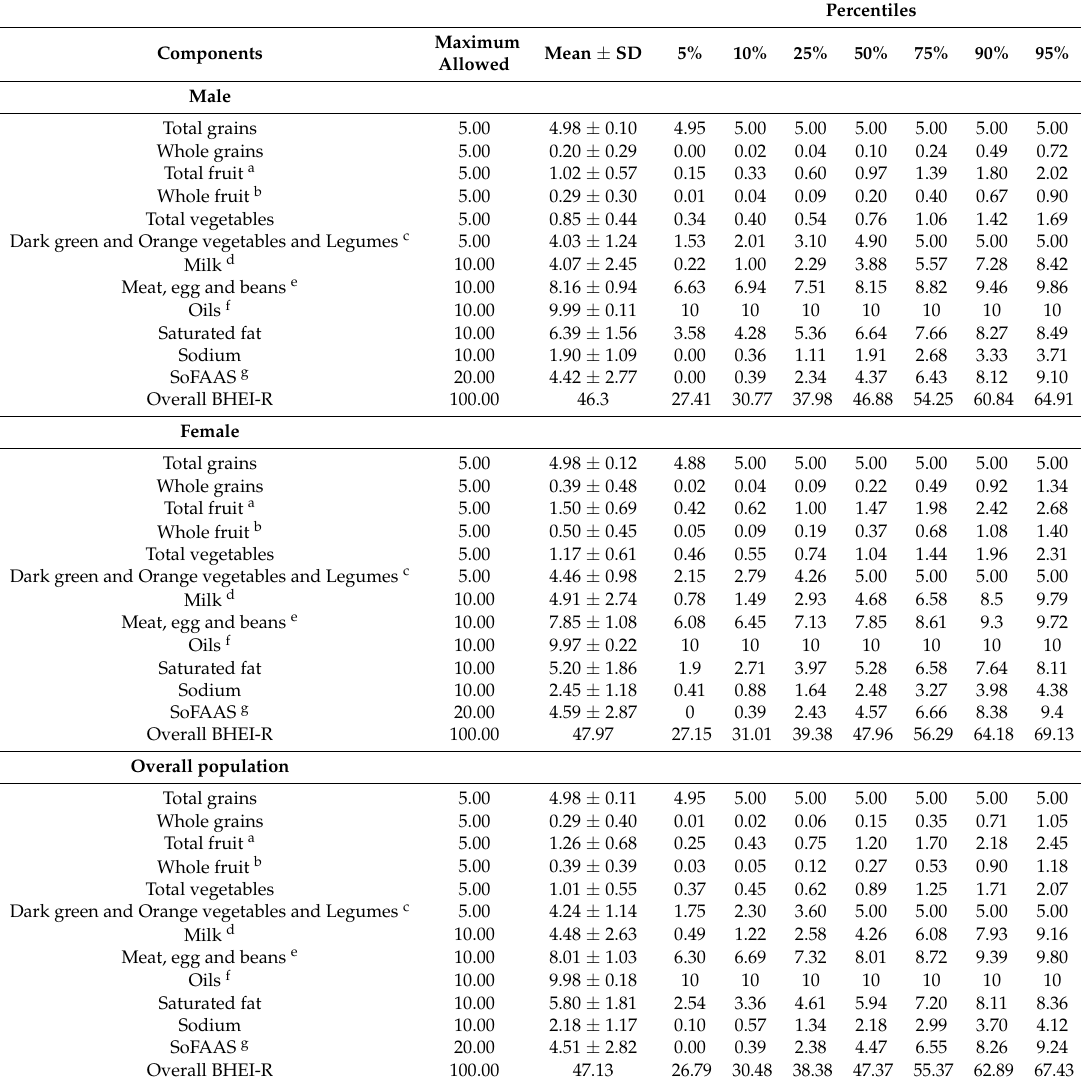
Table 2. Distribution of the total and the components of the Brazilian Healthy Eating Index – Revised (B HEI-R) scores, according to the gender and for the overall population study. São